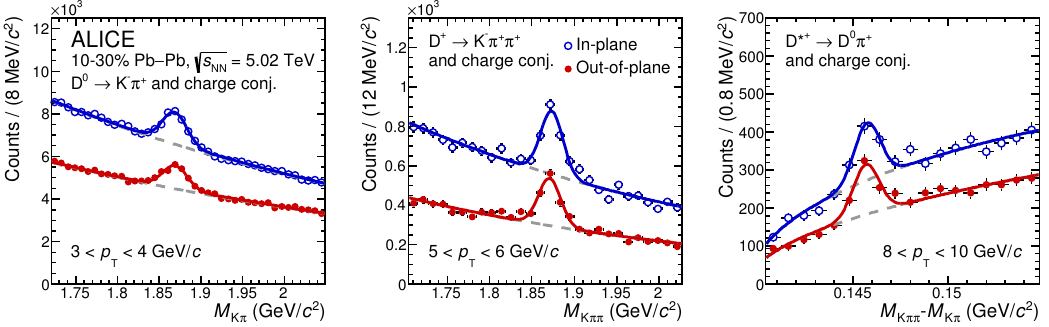
Figure 2 . Invariant-mass distributions of D 0 candidates (left panel), D + candidates (middle panel) and mass-di(cid:11)erence for D (cid:3) + candidates (right panel) in three p T intervals for the two (cid:1) ’ regions used in the EP method for Pb-Pb collisions in the 10{30% centrality class at The solid curves represent the total (cid:12)t functions and the dotted curves the background functions, as described in the